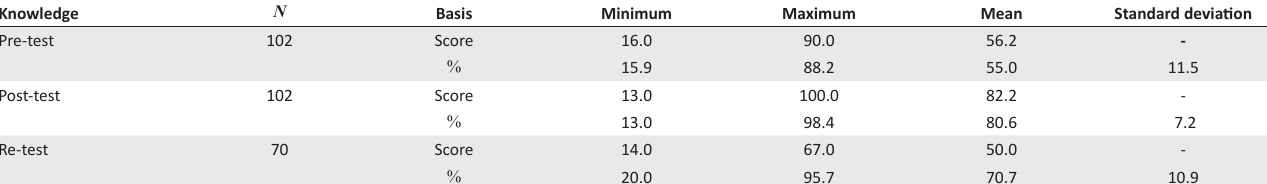
TABLE 3: Registered nurses’ cardiopulmonary resuscitation knowledge. Knowledge